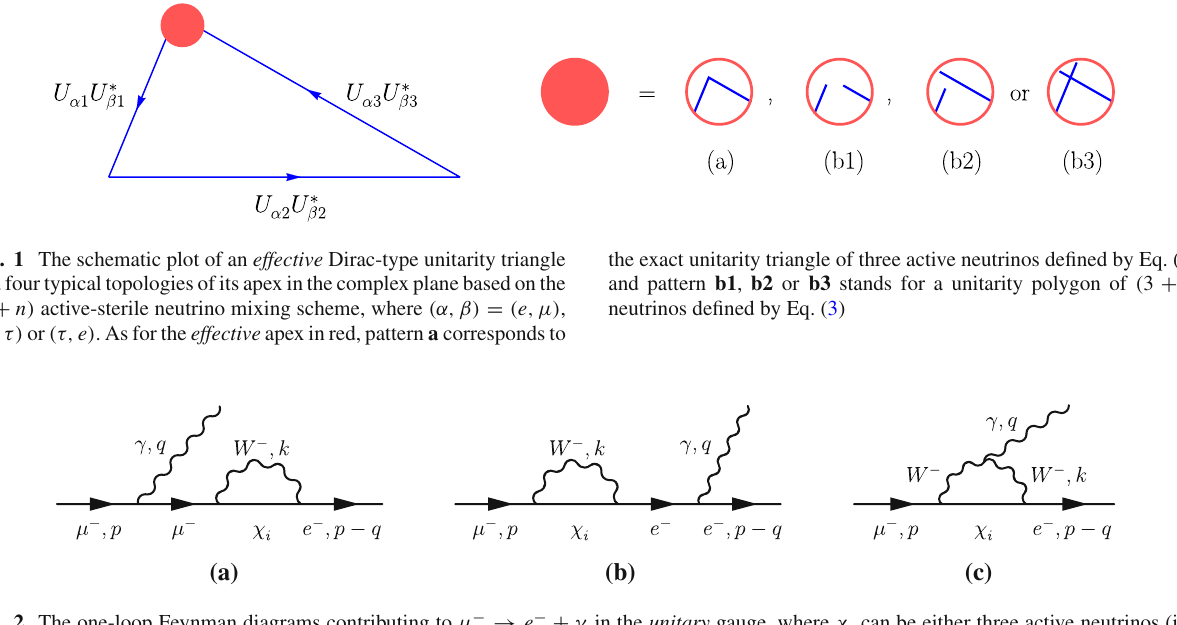
can be either three active neutrinos (i.e., i = N with mass M for i = 1 , 2 ,..., n ) in the ( 3 + n ) active-sterile flavor i + 3 i i